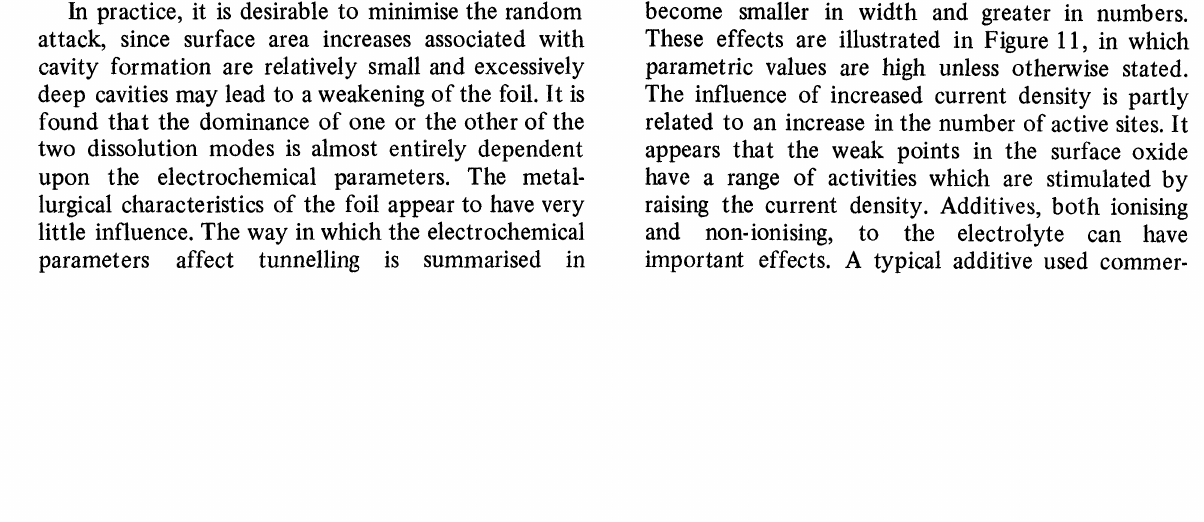
- FIGURE 9 Stages in the development of the tunnel network: (a) 5.0 coulombs cm-2; (b) 8.0 coulombs crn-2 (c) 36 coulombs cm Table II. As the chloride concentration, the rule, both the random and the selective attack occur simultaneously.